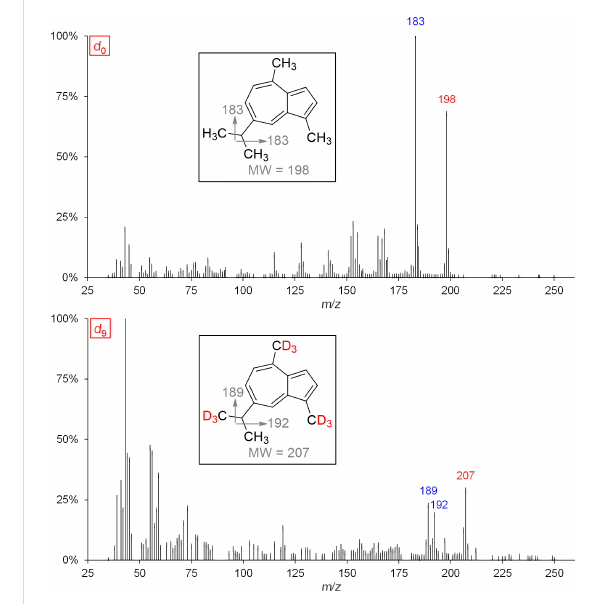
Figure 10: MS spectra and expected labeling patterns of genuine ( d 0 ) and deuterium-labeled ( d 9 ) guaiazulene after feeding experiments